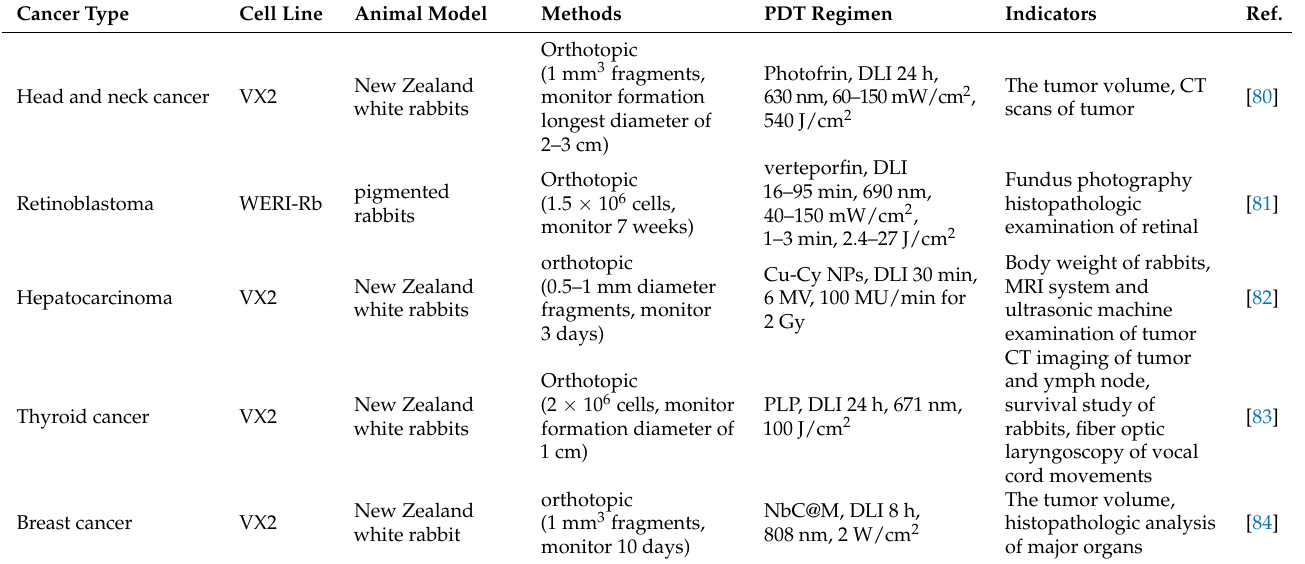
Table 6. Application of rabbits in antitumor study of